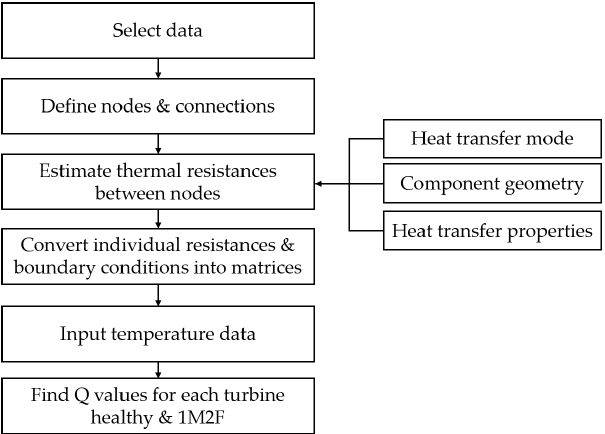
Figure 4. Thermal network model